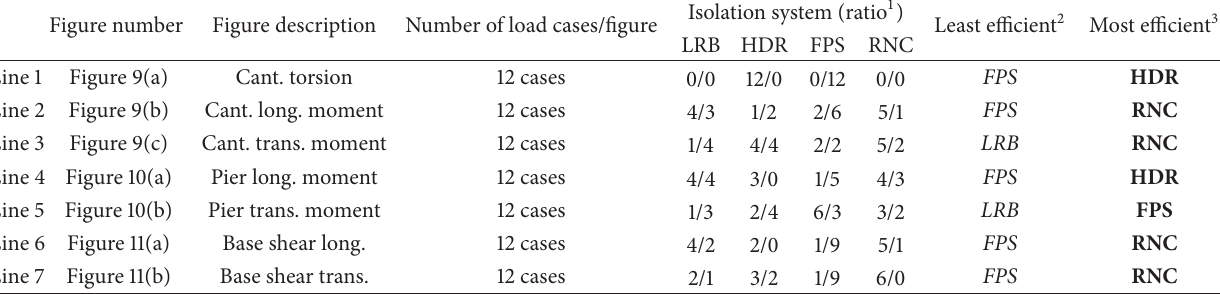
Table 3: Relative efficiency measure of the four isolation systems based on their influence on the bridge’s internal forces. Figure number Figure description